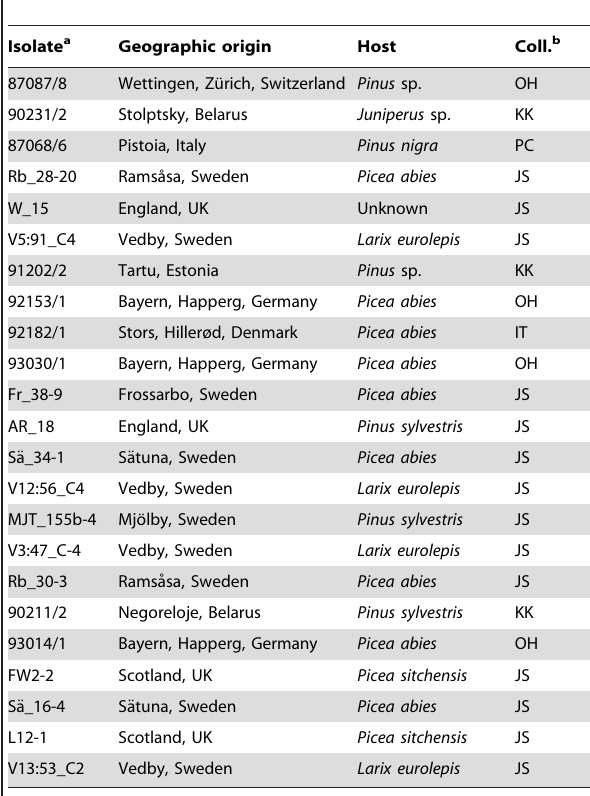
Table 5. Haploid isolates of Heterobasidion annosum s.s. used in the